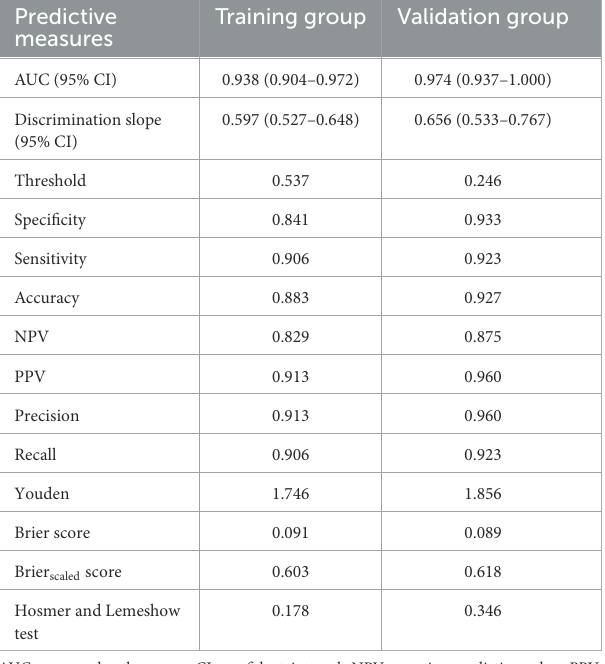
TABLE 4 Predictive measures of the nomogram in the training and validation